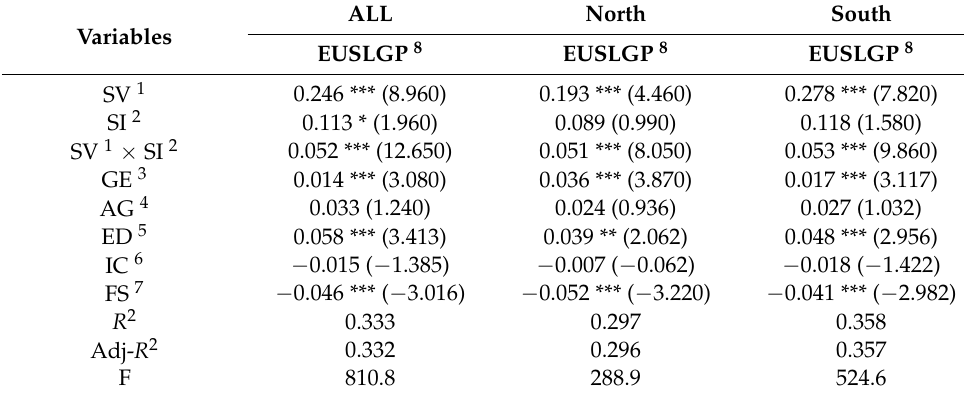
Table 3. Moderating effect test of social